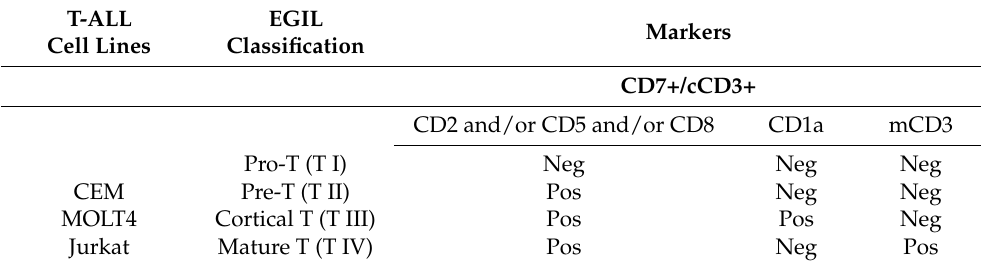
Table 1. T-ALL cell lines according to the EGIL classification. T-ALL EGIL Markers Cell Lines Classification CD7+/cCD3+ CD2 and/or CD5 and/or CD8 CD1a mCD3 Pro-T (T I) Neg Neg Neg CEM Pre-T (T II) Pos Neg Neg MOLT4 Cortical T (T III) Pos Pos Neg Jurkat Mature T (T IV) Pos Neg Pos cCD3: cytoplasmic CD3; mCD3: membrane CD3; Neg: negative; Pos: